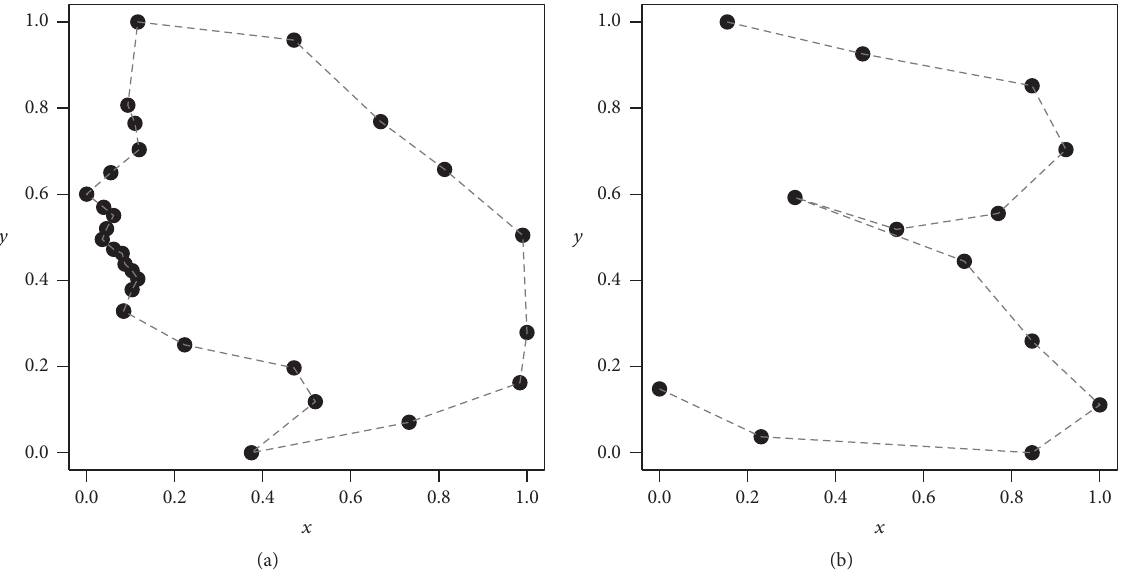
Figure 4: Real datasets: (a) human face and (b) handwritten number 3.